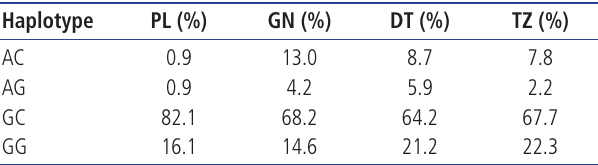
Table 6. Haplotype distribution of single-nucleotide polymorphisms (rs2381 A → G, rs4331 C → G) in the three yak breeds